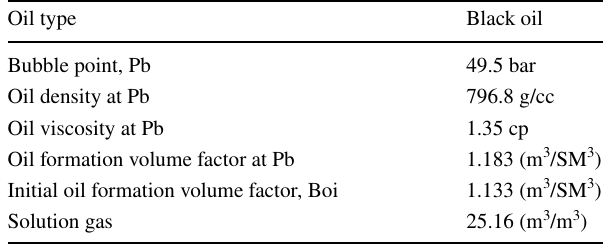
Table 1 Oil characteristics from well R25